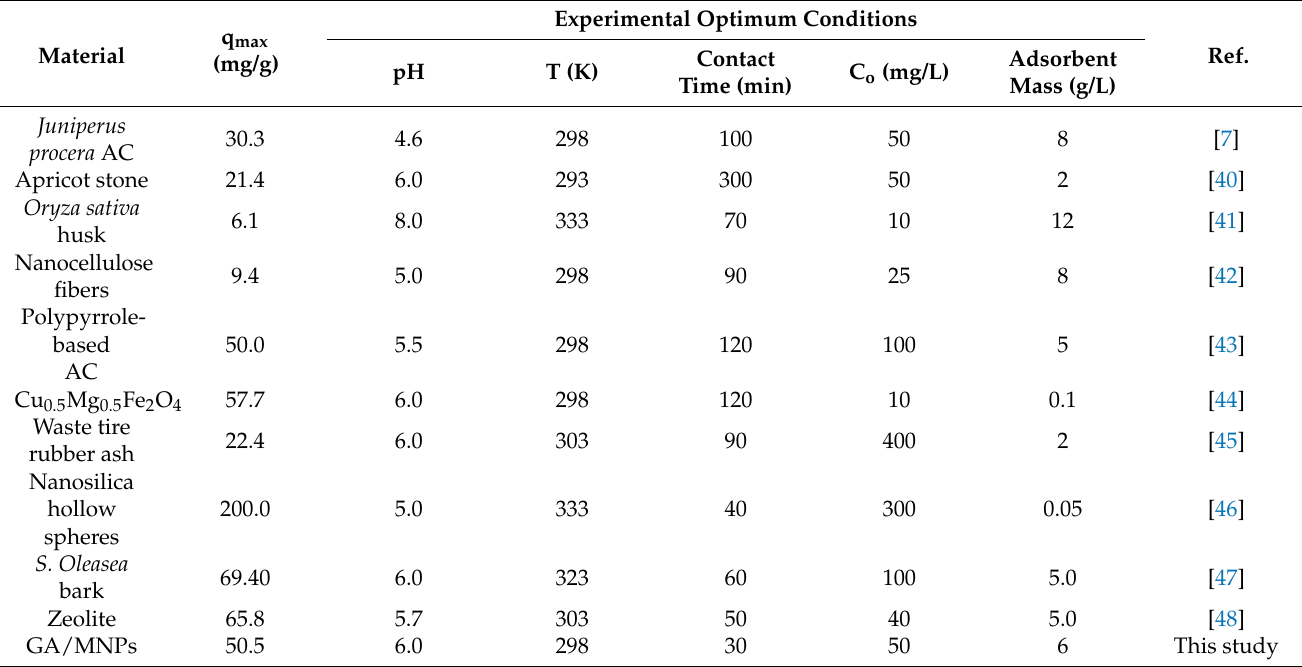
Table 5. Comparison between the maximum uptake capacity and the optimum conditions for various adsorbents.